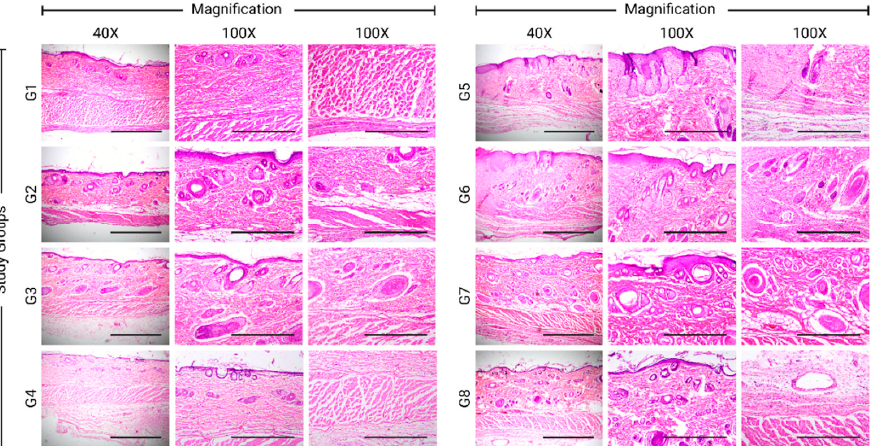
Figure 3. Histopathological evaluation of healed tissues by different treatment groups stained with hematoxylin and eosin (H&E) on day 21. Negative control (G1), petroleum jelly (G2), olive oil (G3), MEBO (G4), 5% H. triquetrifolium ointment (G5), 10% H. triquetrifolium ointment (G6), 100 mg/L H. triquetrifolium olive oil macerate (G7), and 200 mg/L H. triquetrifolium olive oil macerate (G8). 40× scale is 1 mm and 100× scale is 500 µm. The normal skin is composed of a continuous layer of strati fi ed squamous epithelium that is called the epidermis. This layer overlies a dermis layer that is composed of connec- tures (Supplementary Figure S1).